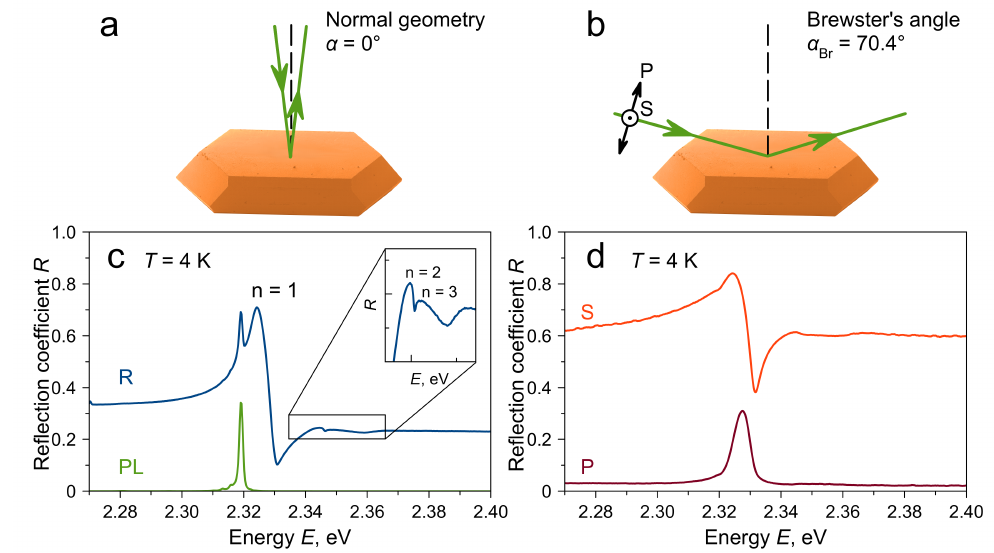
Figure 1. ( a,b ) Experimental arrangements for reflectivity measurements in normal ( a ) and Brew- ster ( b ) geometries. Crystal is represented by a colorized scanning electron microscope image. ( c ) Reflectivity (blue curve) and photoluminescence (green curve) spectra in normal geometry at T = 4 K. Inset shows a magnified region of the reflectivity spectrum with excited excitonic states. ( d ) Reflectivity spectra in Brewster geometry for P-polarized (red curve) and S-polarized (orange curve) incident light at T = 4